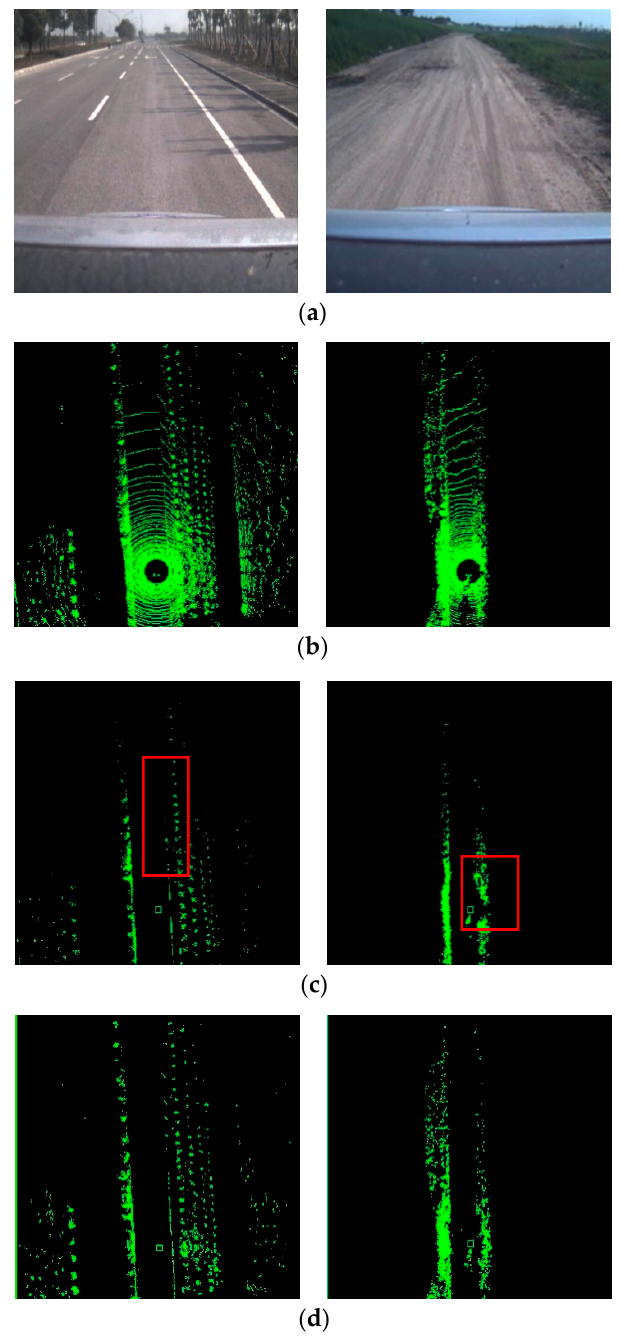
Figure 20. Comparison between the ground segmentation method in [24] and the proposed method. ( a ) Real scene; ( b ) Original point cloud; ( c ) Result of method in [24]; ( d ) Result of the proposed method.